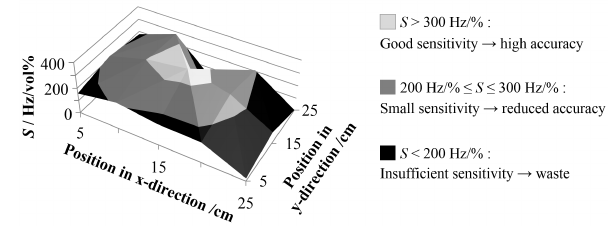
Figure 7. Effect of the inhomogeneous cross-linking temperature distribution in the oven on the resulting sensitivity and functionality of the manufactured sensor.